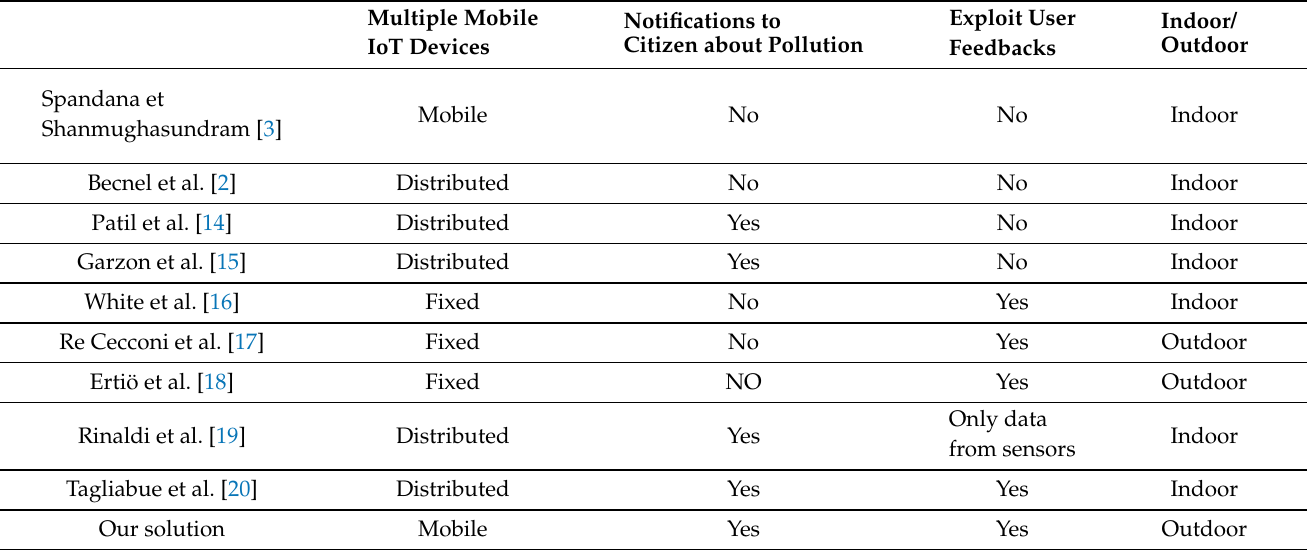
Table 8. Comparison of related works and our